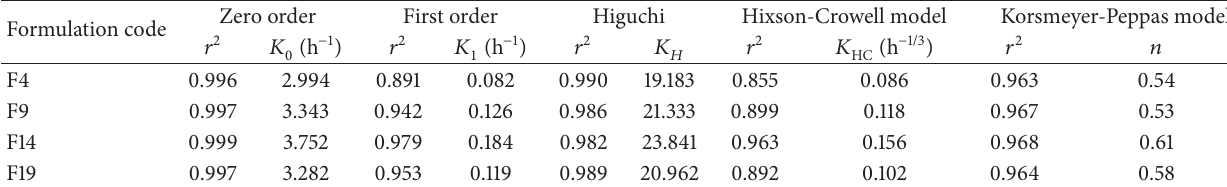
Formulation code